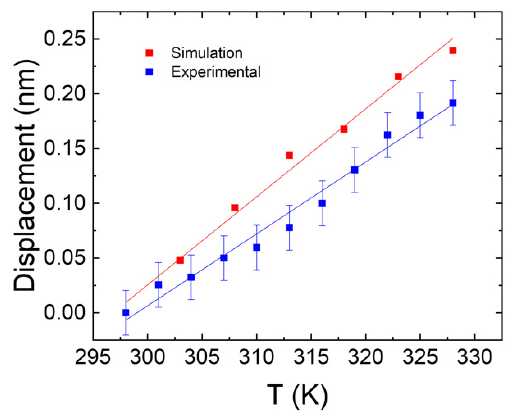
Figure 4. Displacement of the WGM peaks (at 850 nm) as a function of temperature, obtained from experimental data (blue) and simulations (red). The error bars represent the standard error of 20.4